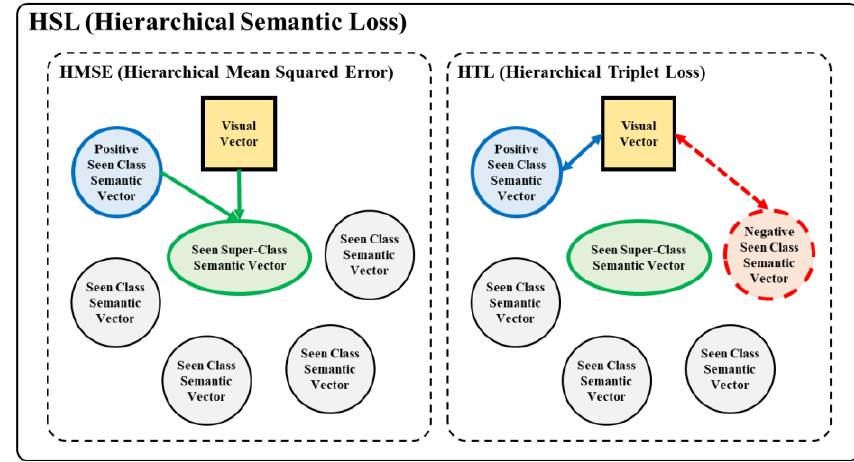
Figure 2. Description of hierarchical semantic loss.